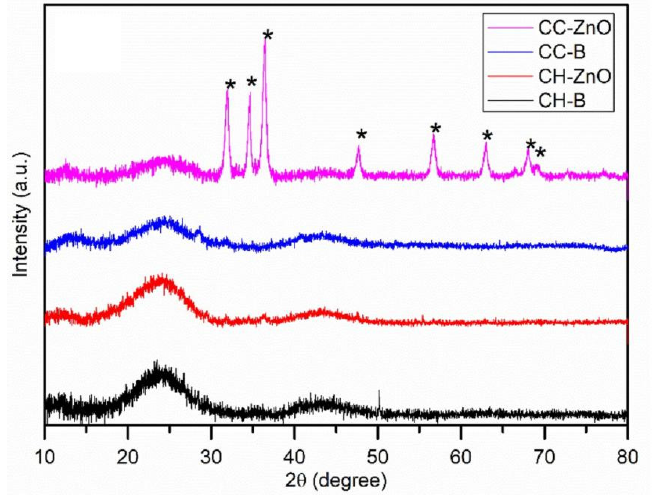
Figure 6. XRD patterns of pristine biochar, Zn-modified biochar, and ZnCl 2 -modified biochar after adsorption of As(III) [108]. Reprinted with permission from Dong Xia et al. (2016). Copyright 2016, Elsevier.